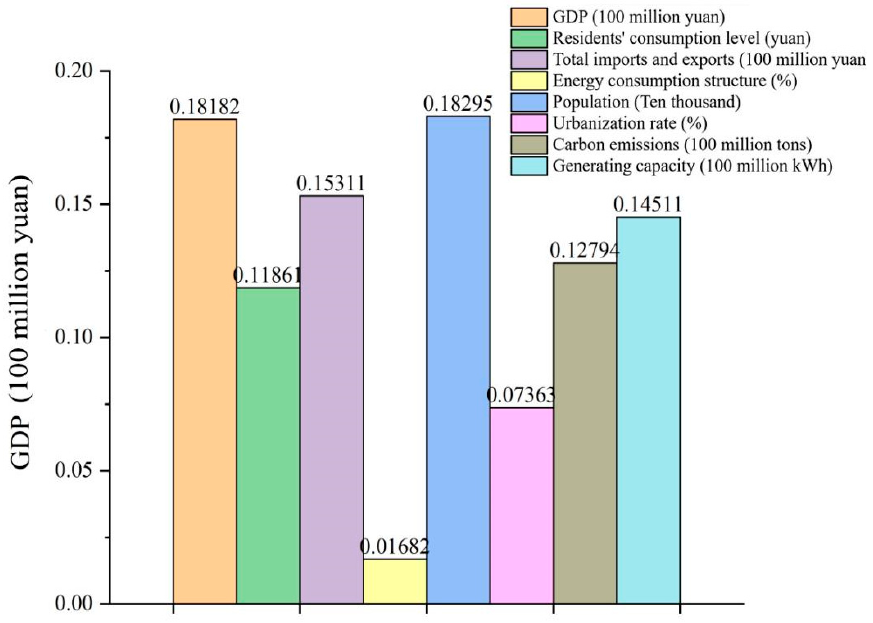
Figure 2. Random forest results.